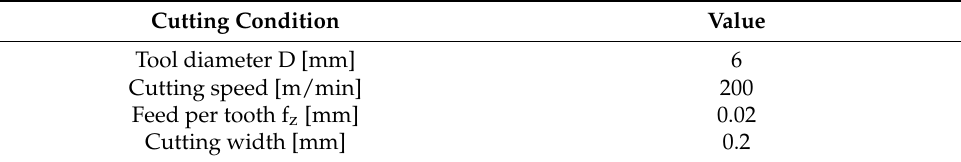
Table 4. Used cutting